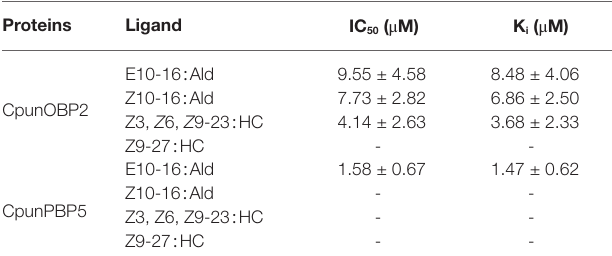
TABLE 4 | IC 50 values ( μ M) and dissociation constants (K i ; μ M) of CpunOBP2 and CpunPBP5 to different sex pheromones at pH = 7.4. Data are shown as mean ± SD, from three